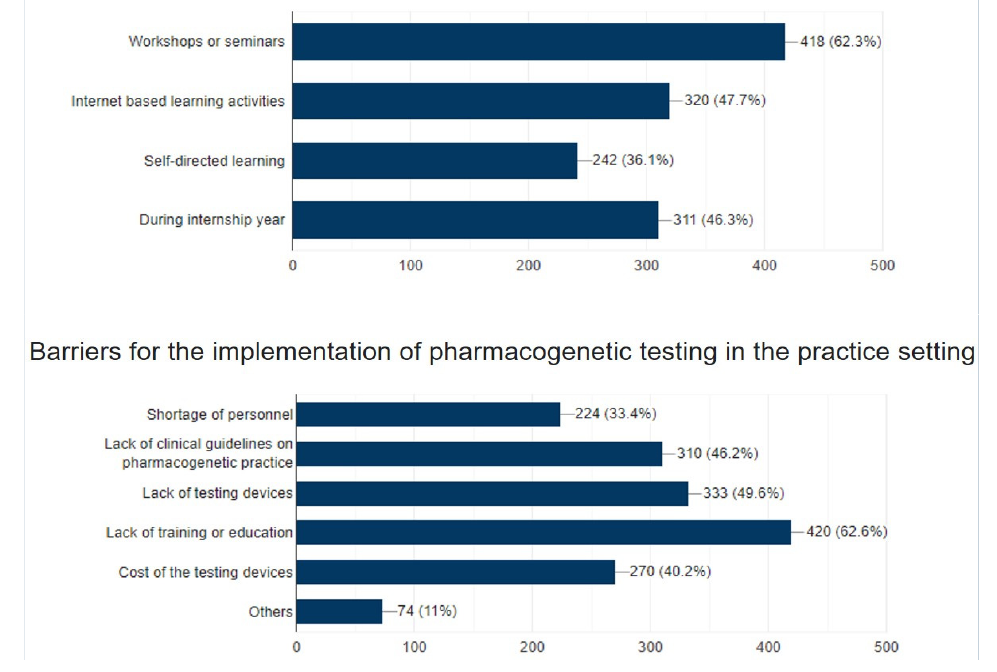
Figure 2. Participants preferred continuing-education program learning styles and the challenges the pharmacists face in implementing pharmacogenetic testing in their clinical practice.